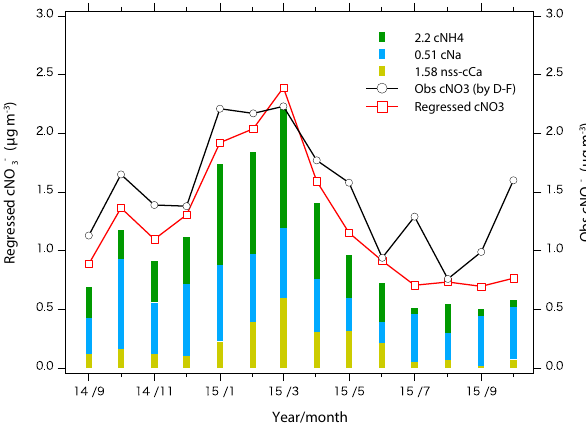
Figure 8. Monthly average multiple regression results for the dust , sea salt cNO − , and cNH + -related cNO − 3 3 4